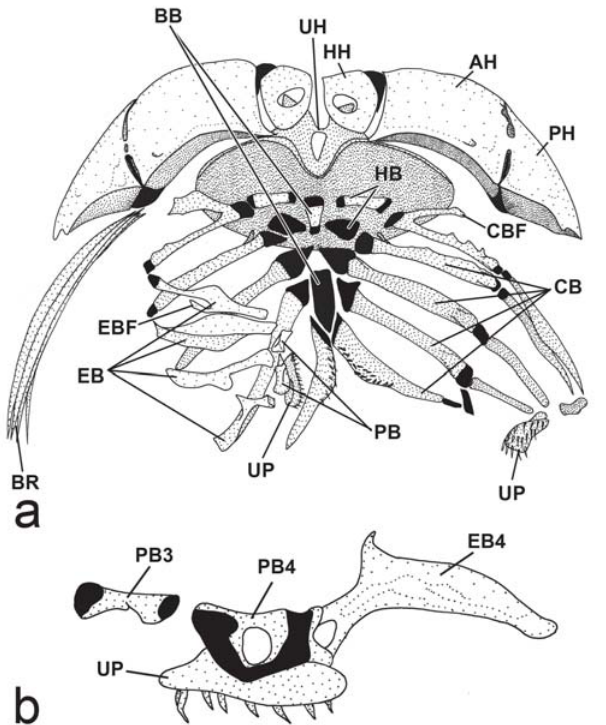
Fig. 5. Otothyropsis marapoama, a) branchial skeleton in dor- sal view, except for upper elements of right side in ventral view, anterior to top, paratype, LIRP 5641, 24.2.mm SL; b) Upper pharyngeal toothplate in lateral view, showing its re- duced condition relative to fourth infra-pharyngobranchial, Anterior to left paratype LIRP 4621, 27.6 mm SL (see Schaefer, 1991, fig. 5 a, b and c for comparisons).